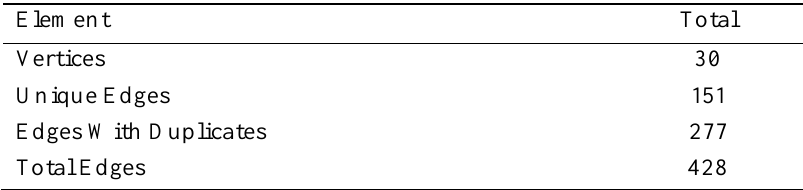
Overall Social Network Metrics for the Initial Four Weeks Element Total Vertices 30 Unique Edges 151 Edges With Duplicates 277 Total Edges 428